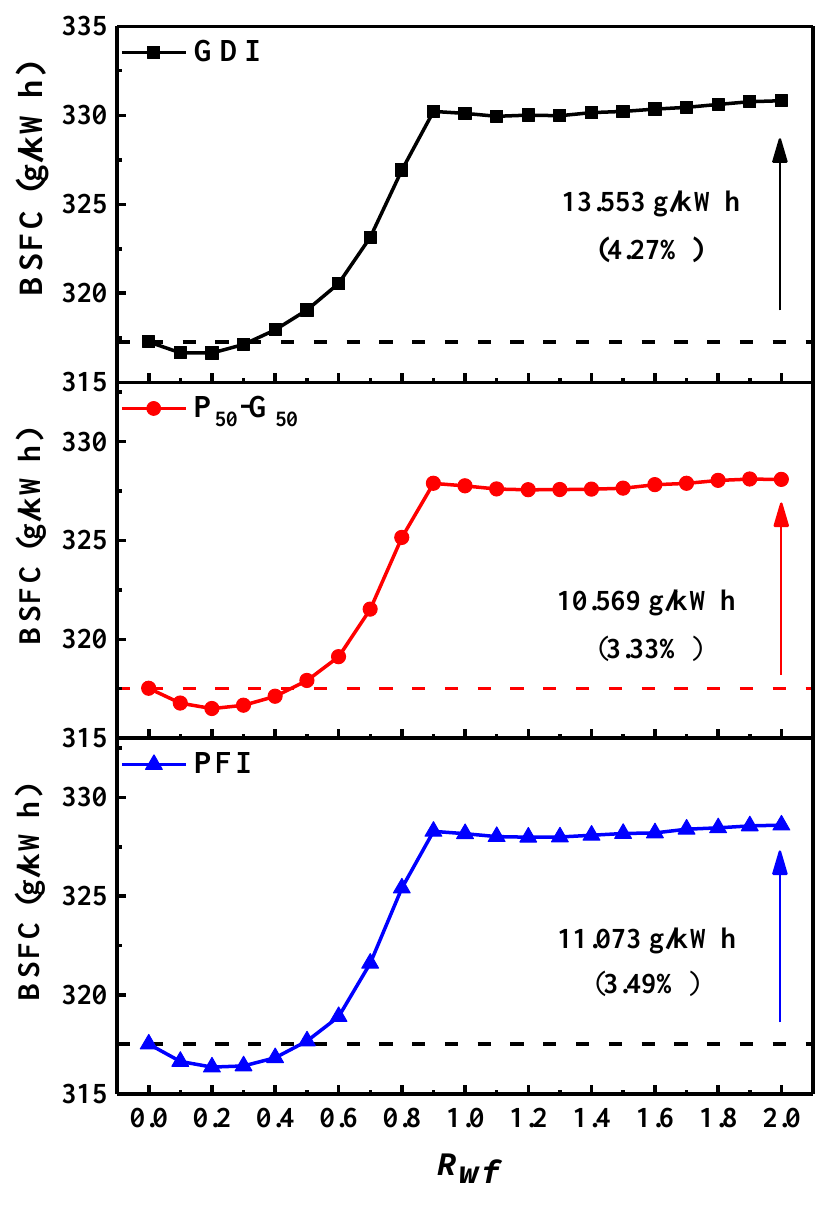
Figure 10. Effects of R wf on BSFC.